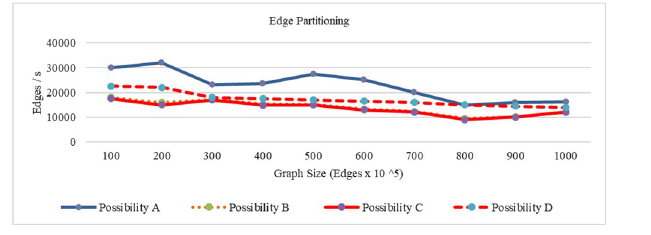
Fig 17. Latency time using edge